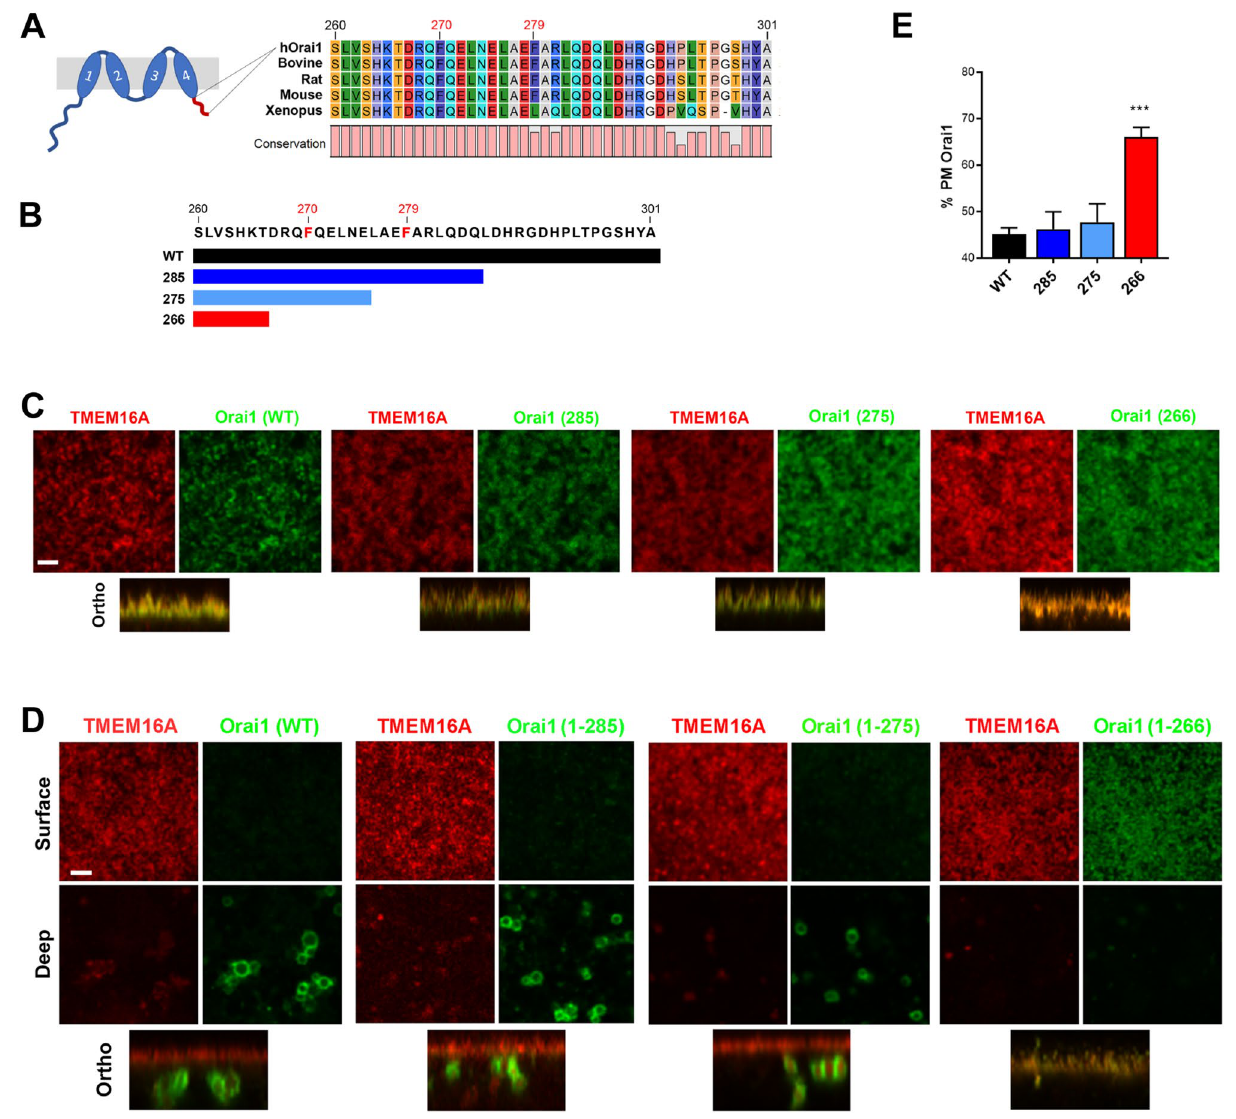
Figure 1. Internalization of Orai1 C-terminal truncations. ( A ) Cartoon of Orai1 with the C-terminus cytoplasmic domain highlighted (red) with its corresponding sequence alignment from various vertebrates. Human (NP_116179), bovine (NP_001092472), mouse (NP_780632), rat (NP_001014004), Xenopus (Q5EAU0). ( B ) Representation of the different Orai1 C-terminal deletions. ( C , D ) Confocal images and orthogonal sections from Xenopus oocytes ( C ) and eggs ( D ) expressing TMEM16A-mCherry with GFP-tagged Orai1 wild-type (WT) or the different deletions (10 ng RNA/oocyte for 48 h) as indicated. Cells were imaged through the PM generating a z-stack of images. Surface indicates the PM focal plane and deep the cytoplasm. Ortho shows an orthogonal cross section across the entire z-stack. Scale is 3 µm. ( E ) Quantification of the percent Orai1